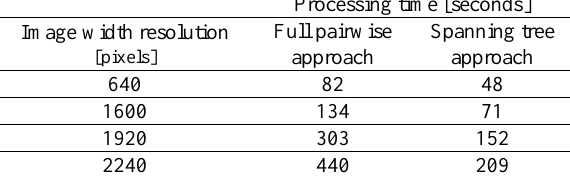
Table 1. The processing time for the full pairwise and the pre- computed spanning tree matching.